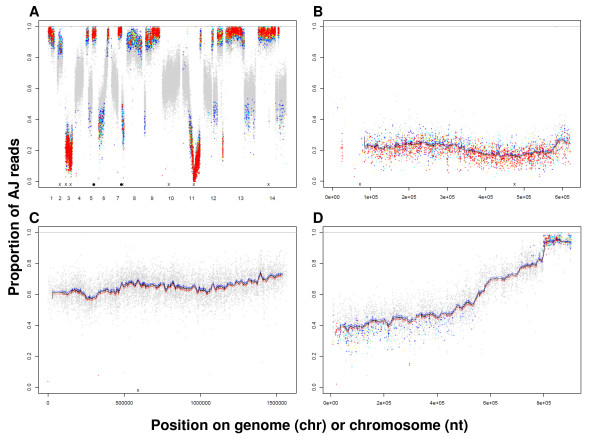
LGS-Illumina - genome-wide scans of chloroquine selection. Datapoint colours encoded as in Figure 3D; A whole genome, B chr03, C chr10, D chr06. Point mutations and indels are indicated by x or filled circles, respectively, at the base of scans, as determined by independent WGS of AS strains AS-sens, AS-30CQ. Corresponding high-resolution pdf files enable detailed inspection of individual SNPs, sliding-window means and standard errors, available from corresponding author on request.